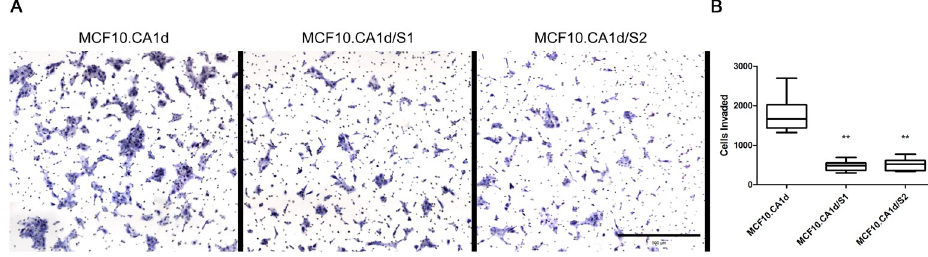
Fig 9. Stable overexpression of Sprouty4 in MCF10.CA1d cells reduces invasion. (A) MCF10.CA1d control and Sprouty4 overexpressing cells (MCF10.CA1d/S1 and MCF10.CA1d/S2) were serum-starved overnight and allowed to invade though 1.5 mg/mL of matrix for 24 hours via Boyden chamber assay. Representative images of cellular invasion (scale bar = 500 μ m). (B) Invasion was quantified and plotted using GraphPad Prism. A Kruskal-Wallis test employing Dunn’s test of multiple comparisons showed significant differences in invasion when comparing Sprouty4 overexpression lines to control ( α = 0.01, 99% CI; �� p < 0.01). Whiskers represent the minimum and maximum values and bars represent the median. Data were collected from three independent